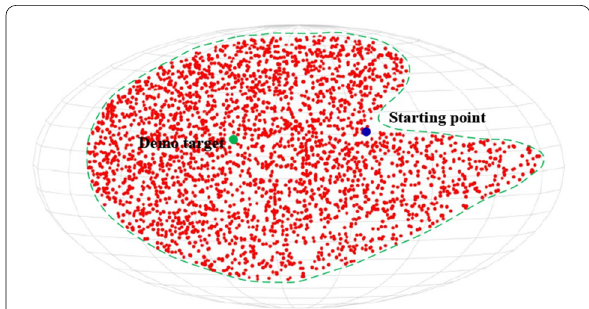
Figure 5 Satisfactory generalized region with e r =